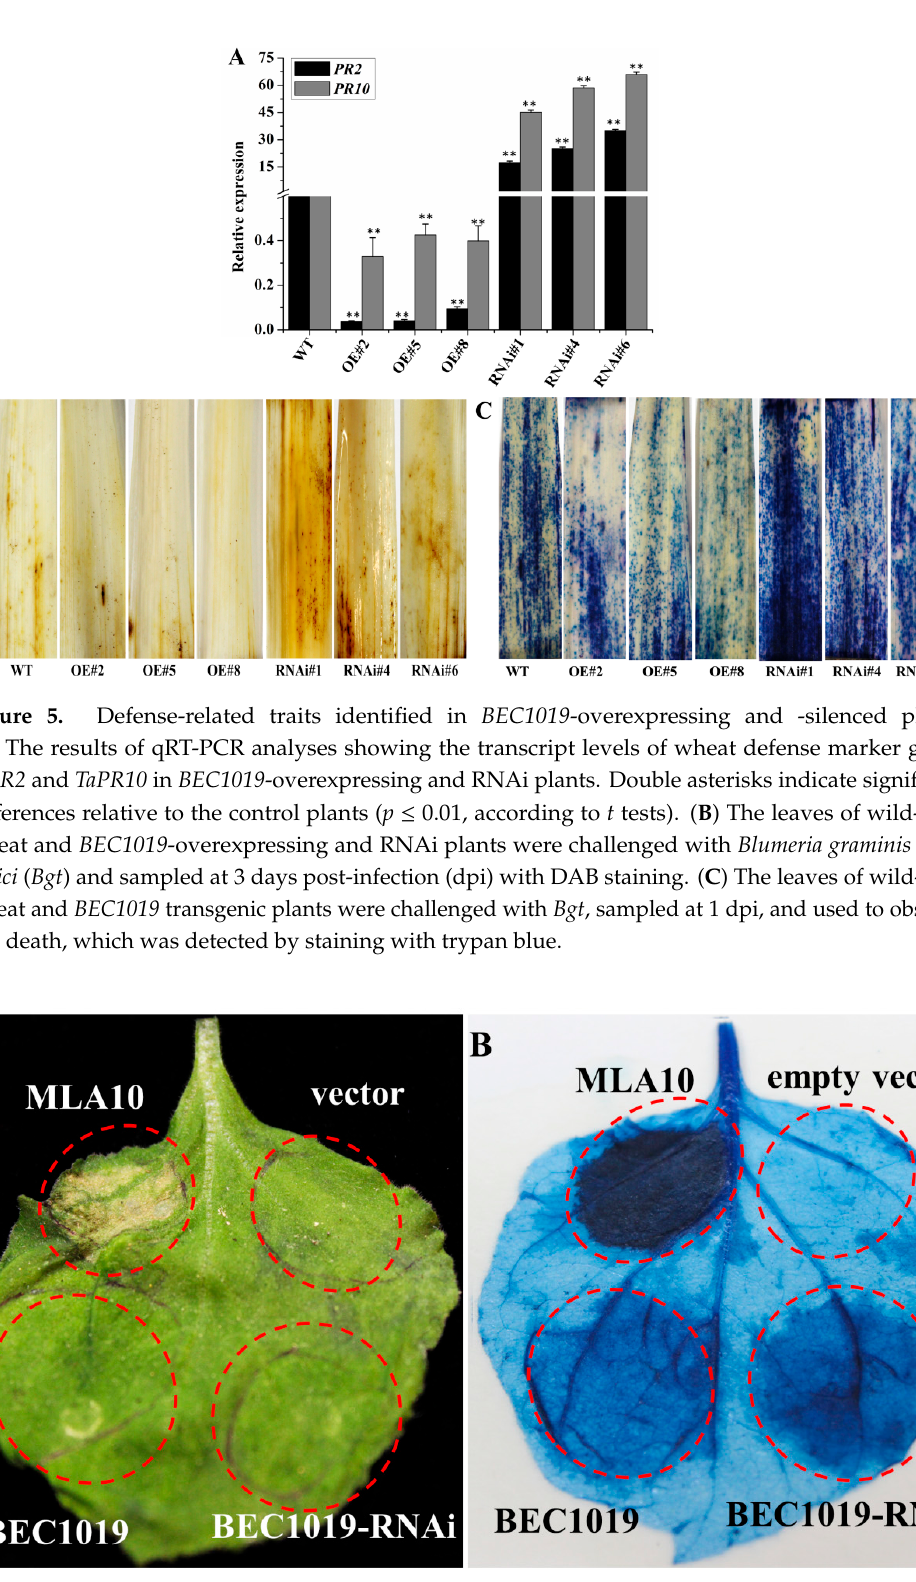
Figure 6. Analysis of cell death triggered by BEC1019 in Nicotiana benthamiana . The barley resistance gene MLA10 (positive control) and full-length and RNAi partial sequences of BEC1019 were expressed via agro-infiltration in N. benthamiana ( A ), and cell death representing HR was visualized by trypan blue staining ( B ) at 5 days post-agro-infiltration. No HR induction was detected in the negative control (empty vector).